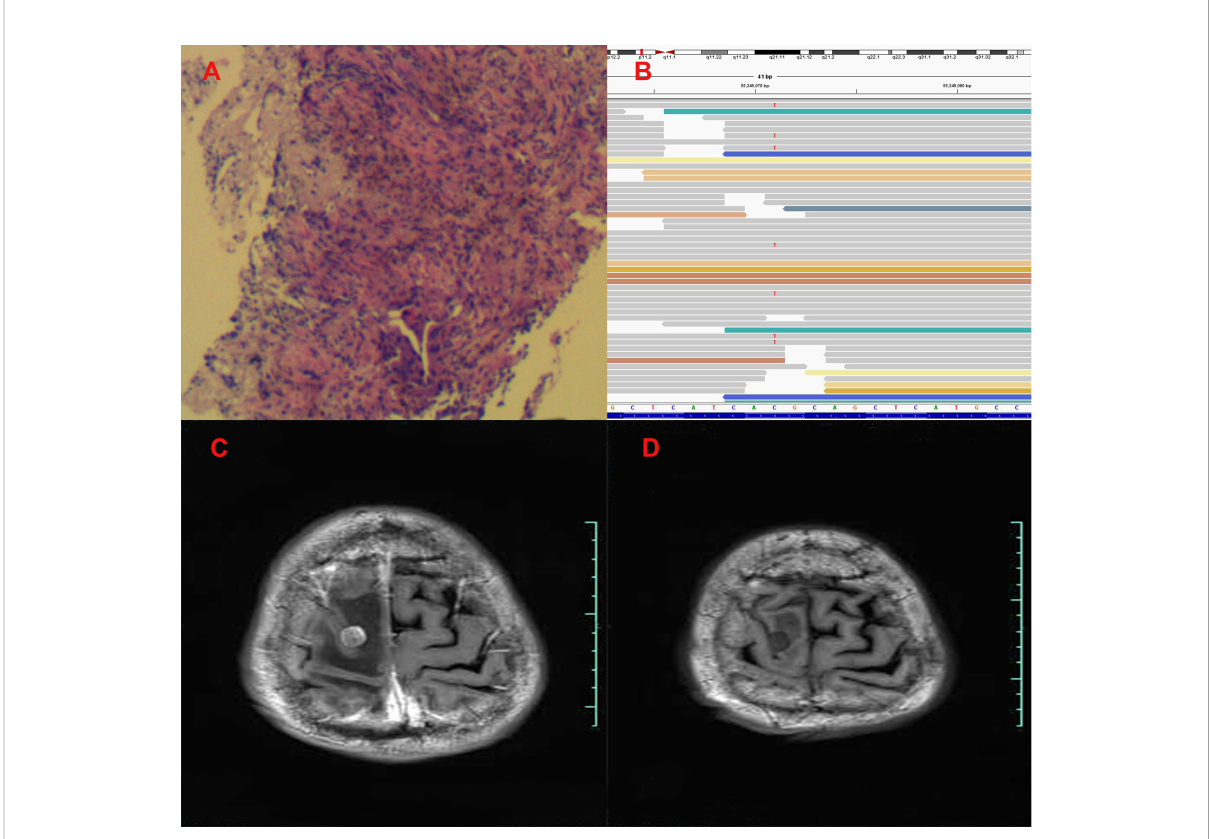
FIGURE 2 Pathological and clinical fi ndings of Patient 2. (A) Pathological fi ndings with HE staining. (B) NGS screenshots suggested emerging EGFR exon 20 T790M mutations. (C) Brain MRI image before salvage almonertinib treatment (after the emerging T790M mutation). (D) Brain MRI image after salvage almonertinib